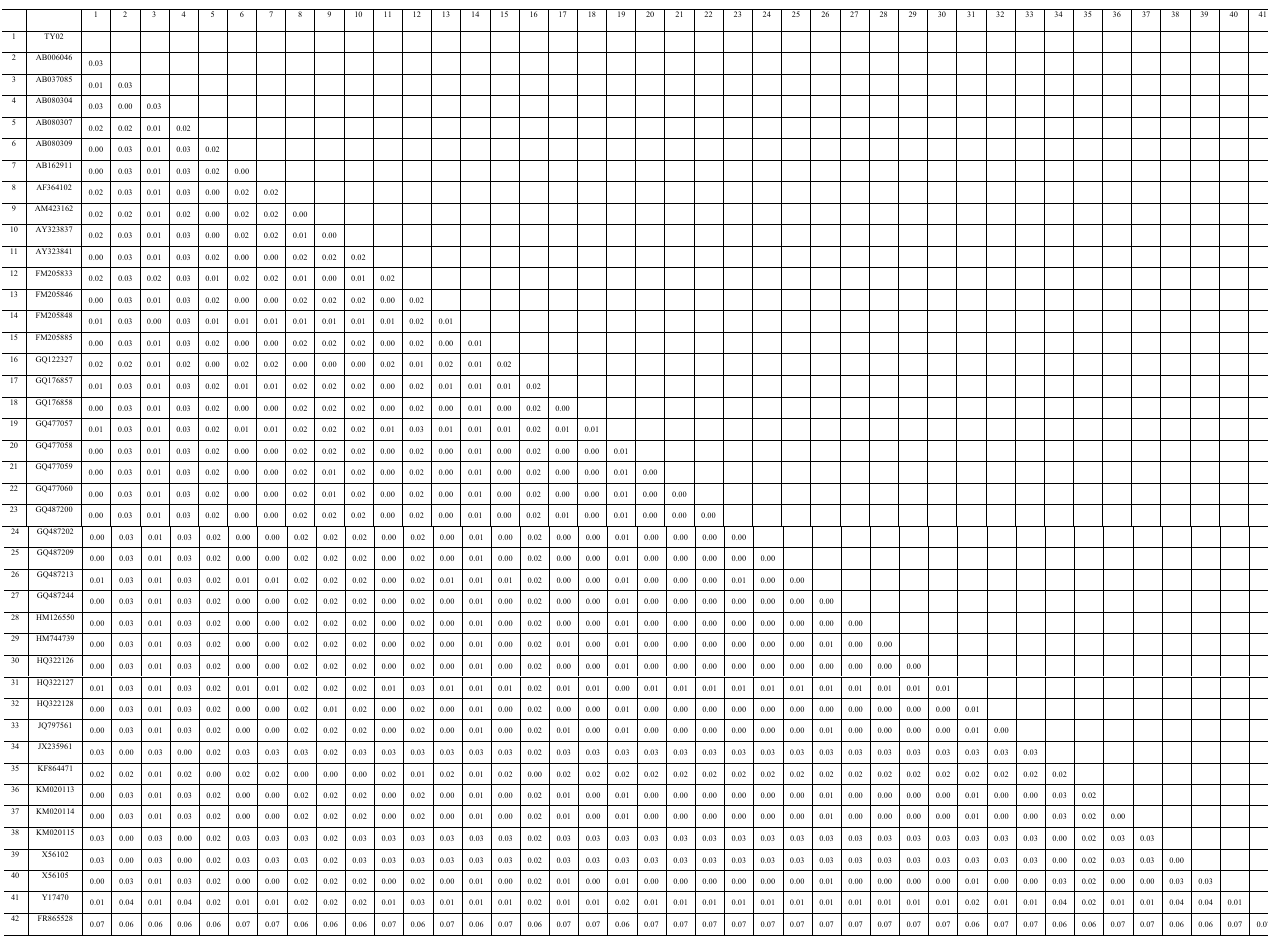
Tab. S3: Pairwise p-distances based on 18S rDNA sequences of